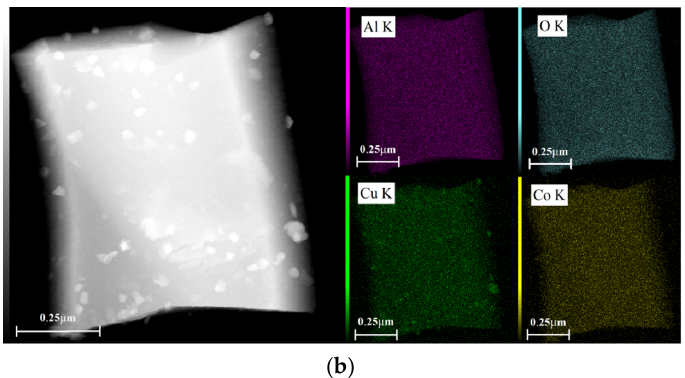
Figure 6. TEM-EDX dot-mapping analyses of the ( a ) 5Ni5CuAl and ( b ) 5Co5CuAl catalyst samples. SAED patterns and their corresponding TEM images (inset) are shown in Figure 7. The SAED patterns of the 5Ni5CoAl sample consist of continuous concentric rings that could be assigned to the α−Al 2 O 3 (300) plane, the CoAl 2 O 4 (440) plane, and to the NiAl 2 O 4 (400), (311) and (220) planes. For the 5Ni5CuAl sample, the diffraction spot forms concentric rings corresponding to the α−Al 2 O 3 (300) plane, NiAl 2 O 4 (440) and (400) planes, and to the CuO (111) and (002) planes. For the 5Co5CuAl sample, five diffraction rings are observed, which could be indexed as the CuO (220), (111) and (110) planes, as well as the CoAl 2 O 4 (440) and (331) planes. TEM results suggest the presence of NiAl 2 O 4 or CoAl 2 O 4 “surface spinels” in the Ni- or Co-containing catalysts, while the formation of “bulk-like” CuO nanoparticles in the Cu-containing catalysts was confirmed. These observations were associated to the well-known interaction between alumina and transition metal oxides. Indeed, incorporated nickel or cobalt oxides develop two-dimensional (2D) nanostructures, forming well-dispersed CoAl 2 O 4 and NiAl 2 O 4 “surface spinels”. On the other hand, copper oxides that do not interact with alumina develop three dimensional (3D) crystallites. Neither nickel and cobalt oxides nor alloy systems were observed in all the samples, which is in accordance with the XRD results.